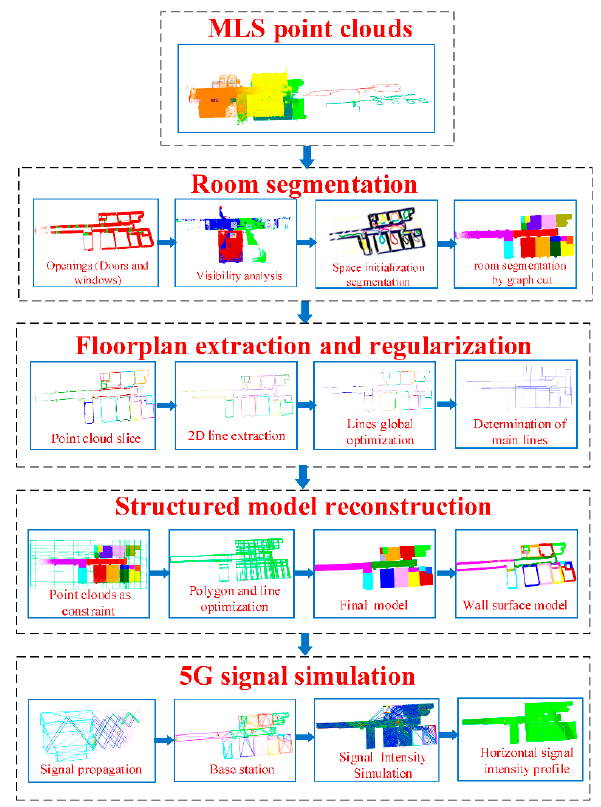
Figure 1. Flowchart of the proposed method.